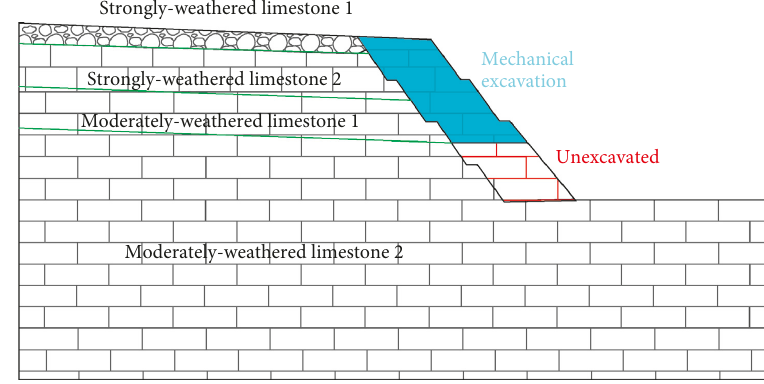
Figure 2: Section locations of the blasting area. Table 1: Parameters of this blasting.